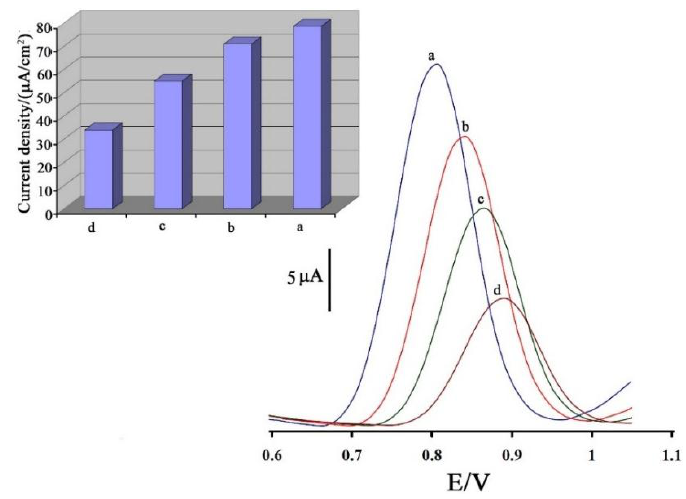
Figure 3. Square wave voltammograms of ( a ) 1,3-DIBr/ZnO/CNTs/CPE; ( b ) 1,3-DIBr/CPE; ( c ) ZnO/CNTs/CPE and ( d ) CPE in presence of 100 μM vitamin B 9 at pH 9.0, respectively. Inset: The current density derived from square wave voltammograms responses of 100 μM vitamin B 9 at pH 9.0 at the surface of different electrodes.